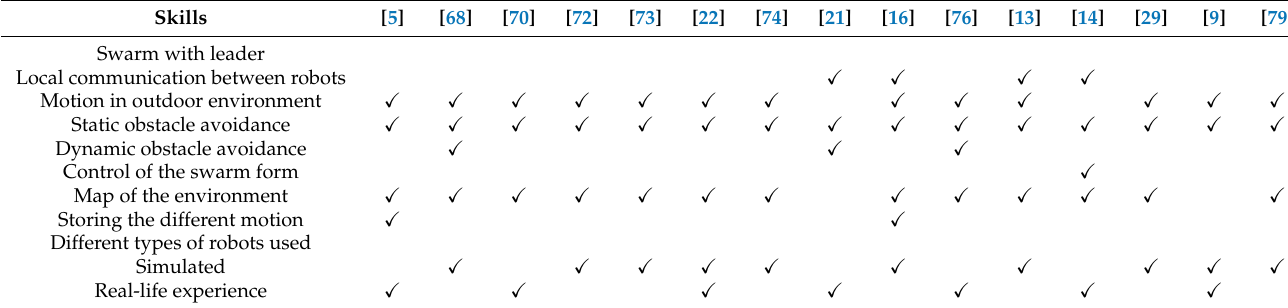
Table 5. Comparison of different algorithms for decentralized and undistributed swarm. Skills